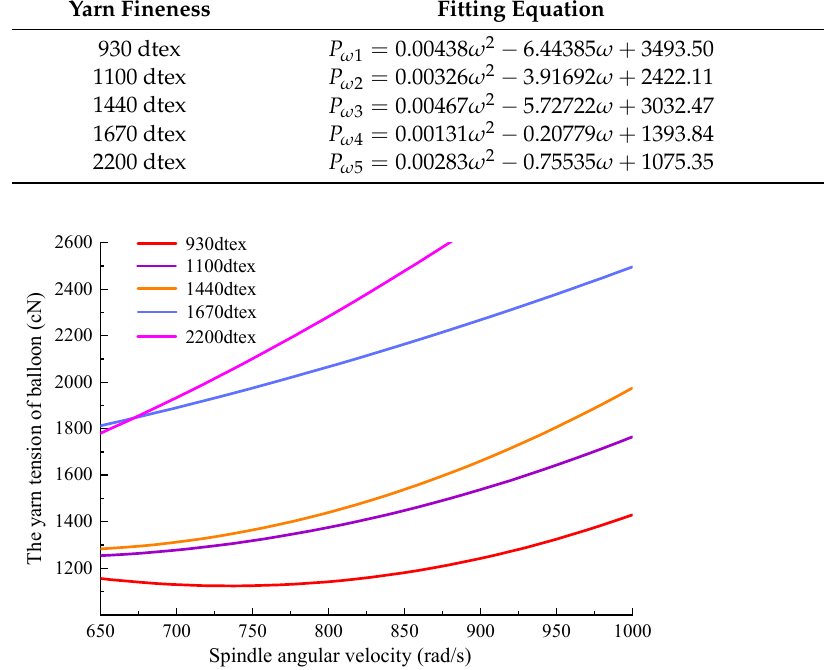
Figure 7. Fitting curves of balloon yarn tension and spindle angular velocity under different yarn fineness.